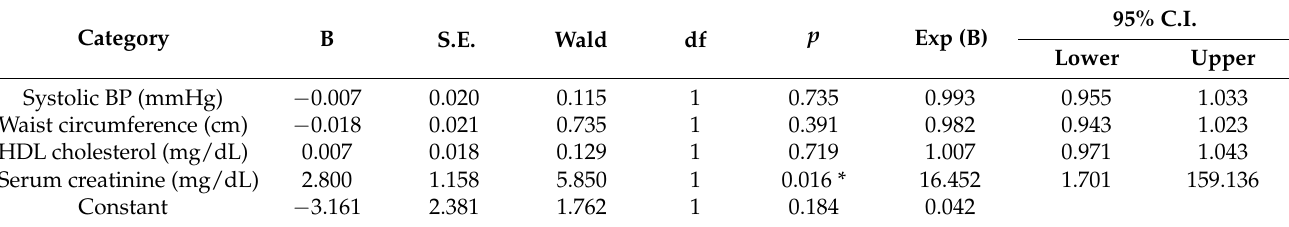
Table 4. Risk Factors for Metabolic Syndrome (N =